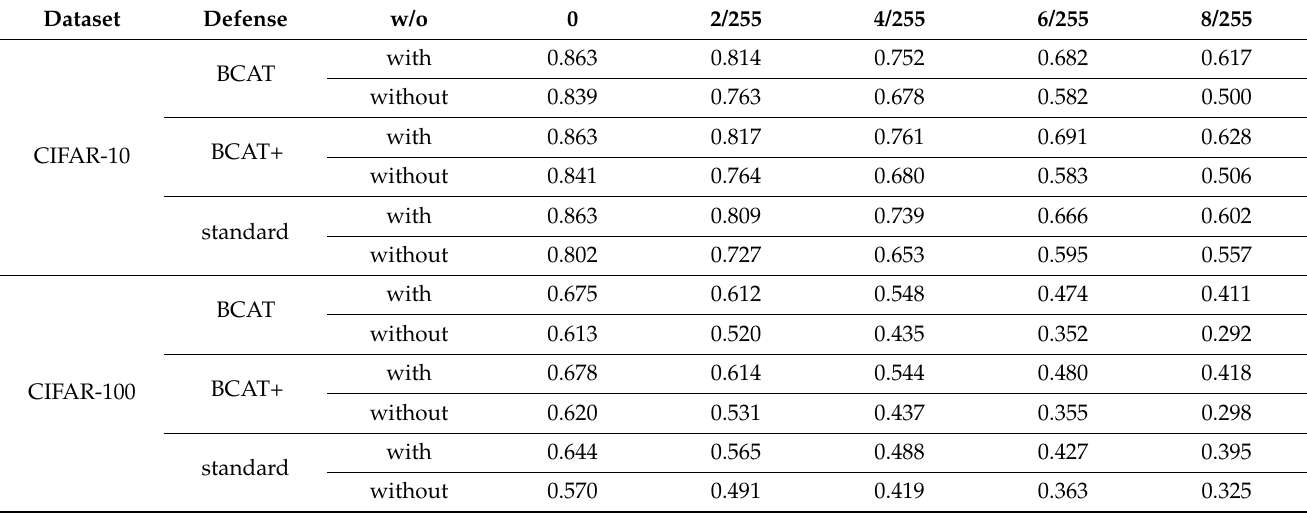
Table 7. Ablation study on data augmentation.